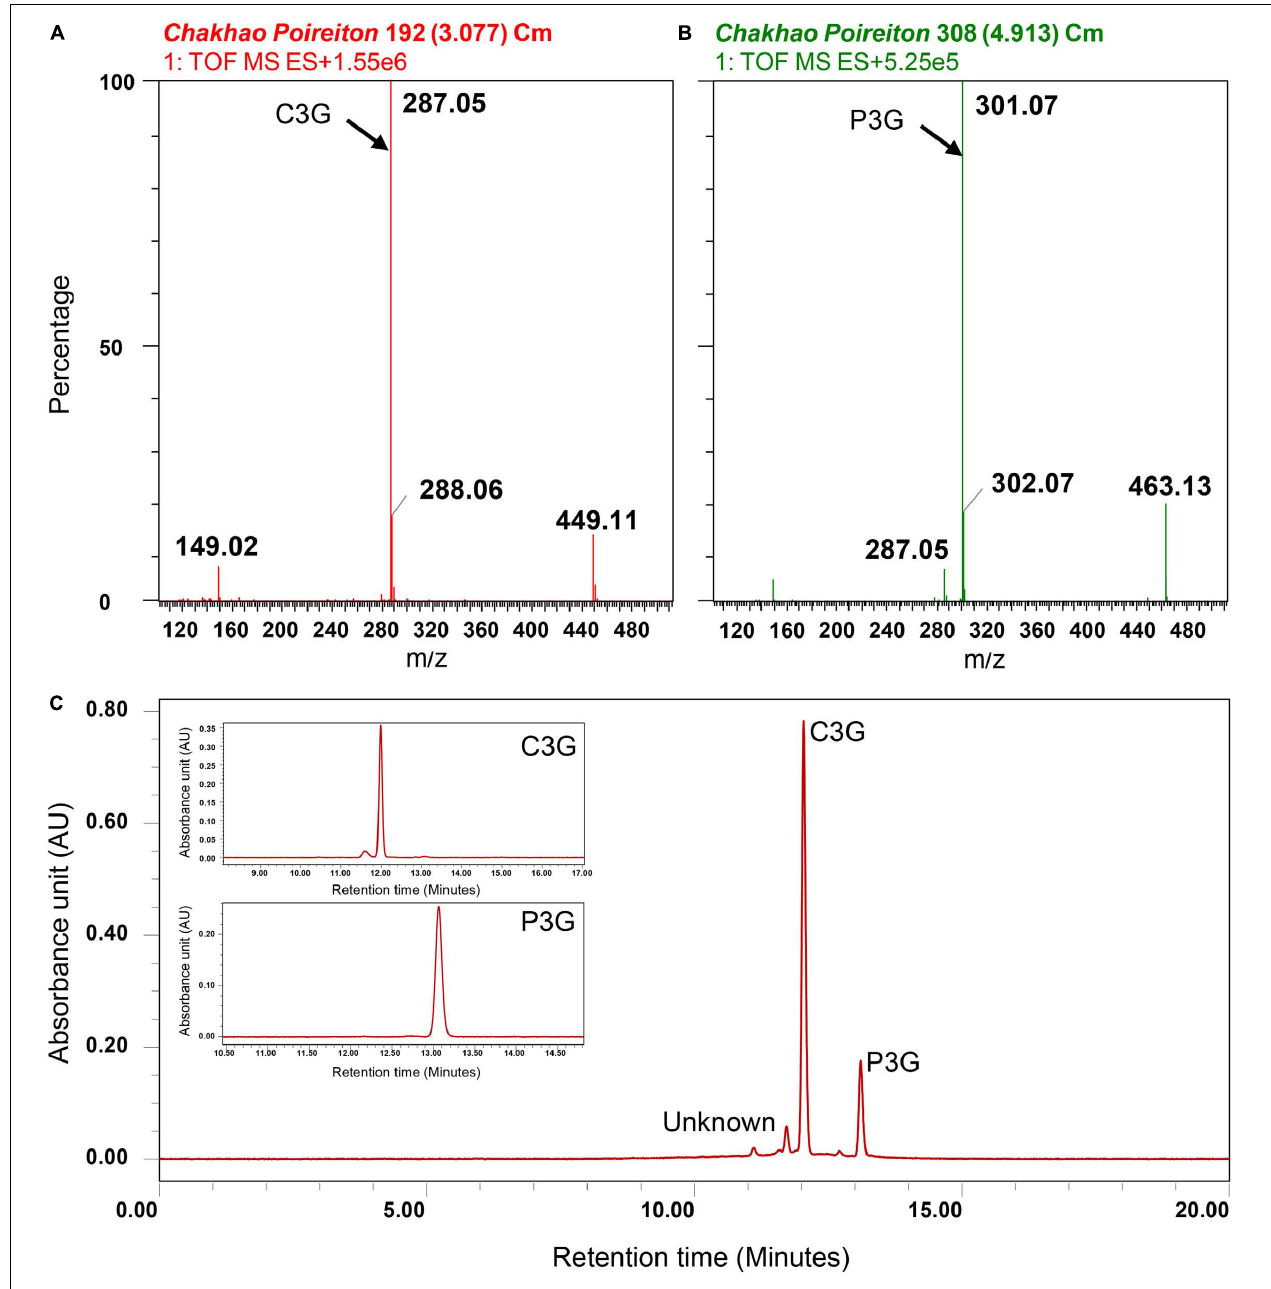
FIGURE 8 | Identification of anthocyanins in Manipur black rice cultivar Chakhao Poireiton. MS spectra depicting (A) cyanidin-3-o-glucoside (C3G) fragments, (B) peonidin-3-o-glucoside (P3G) fragments. Quantification of identified anthocyanins by high-performance liquid chromatography (C) Chromatogram of Chakhao Poireiton , with standard C3G and P3G peaks as